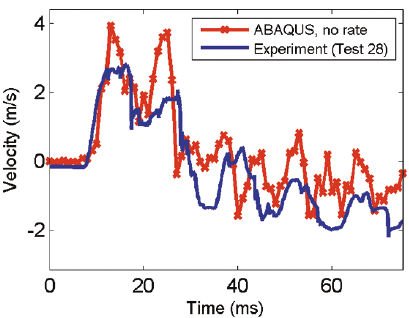
Fig. 16. Comparison with experimental velocity data, dynamic ten- sion test.